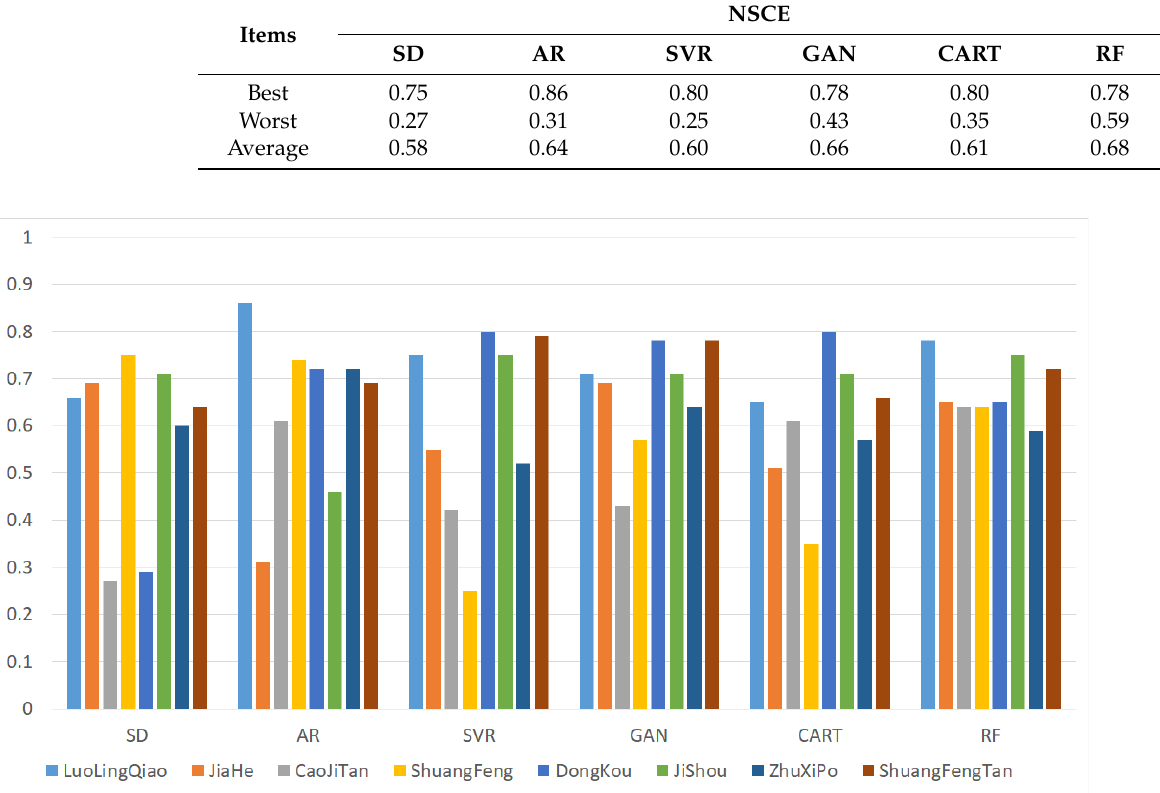
Table 10. NSCE statistical results.